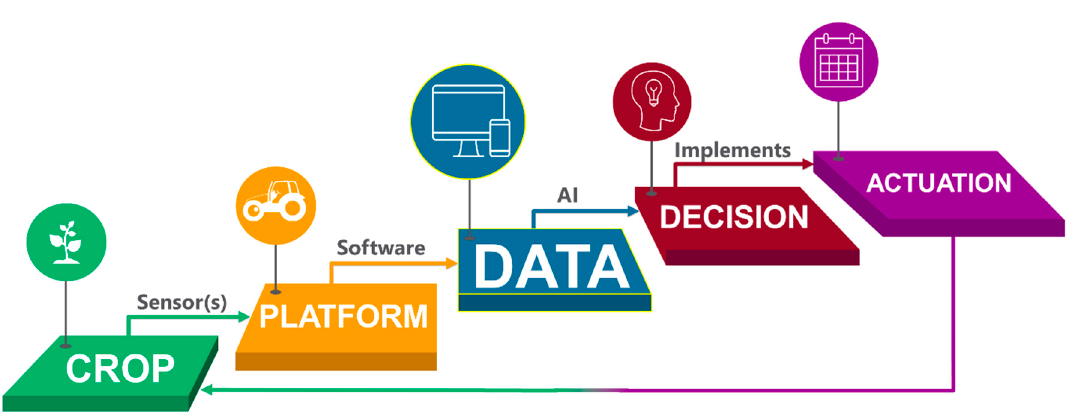
Figure 1. Information-based management cycle for advanced agriculture. Table 1. Classification of the research articles referenced in the present study.